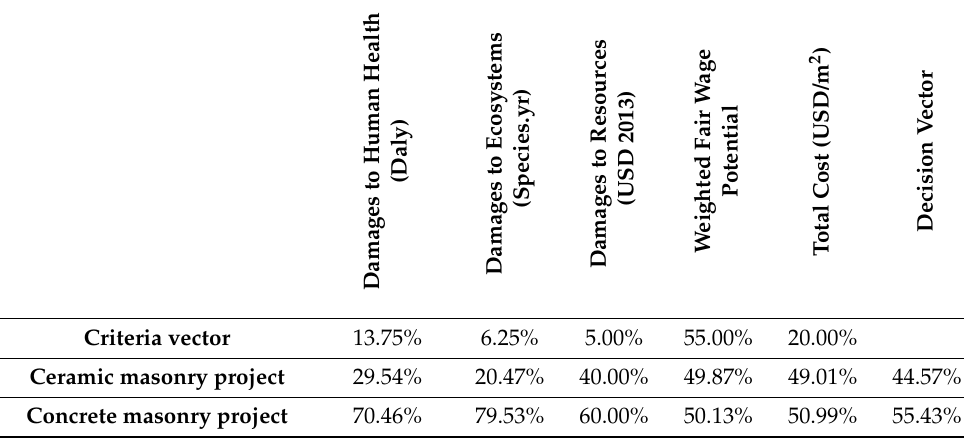
Table 14. Individualist perspective: sustainability.